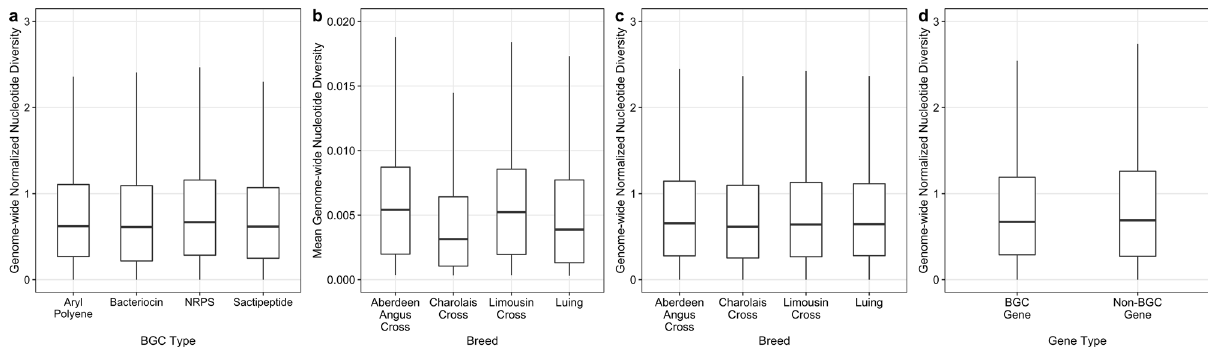
Fig. 6 Comparison of the microdiversity of MAGs and BGCs from cattle metagenomes in the Stewart et al. studies 4, 5 . The within-sample nucleotide diversity of BGCs was statistically different between BGC types, but the effect size of the difference was small ( ε 2 = 0.001) ( a ). The difference in nucleotide diversity across breeds was greater for MAGs ( ε 2 = 0.0265) ( b ) than for genes in BGCs ( ε 2 = 0.0003) ( c ). Additionally, the effect size of the difference between the normalized nucleotide diversity of genes from BGCs and other genes was small (Vargha and Delaney ’ s A = 0.507) ( d ). Genome- wide normalized nucleotide diversity is the nucleotide diversity of a gene relative to the mean nucleotide diversity of the MAG. The genome-wide normalized nucleotide diversity metric was used to reduce the in fl uence of lineage-speci fi c evolutionary processes, allowing for a more accurate comparison of gene nucleotide diversity across microbial populations. The same conclusions were identi fi ed using the raw nucleotide diversity in the place of genome-wide normalized nucleotide diversity. The outlier points have been removed from the boxplots for